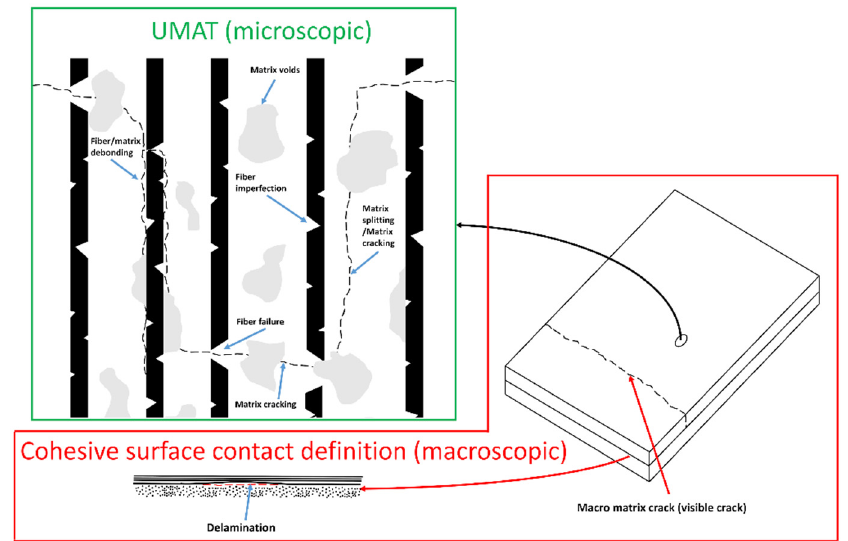
Figure 4. Overview of the failure mechanisms and which modelling method covers which mecha- nism.